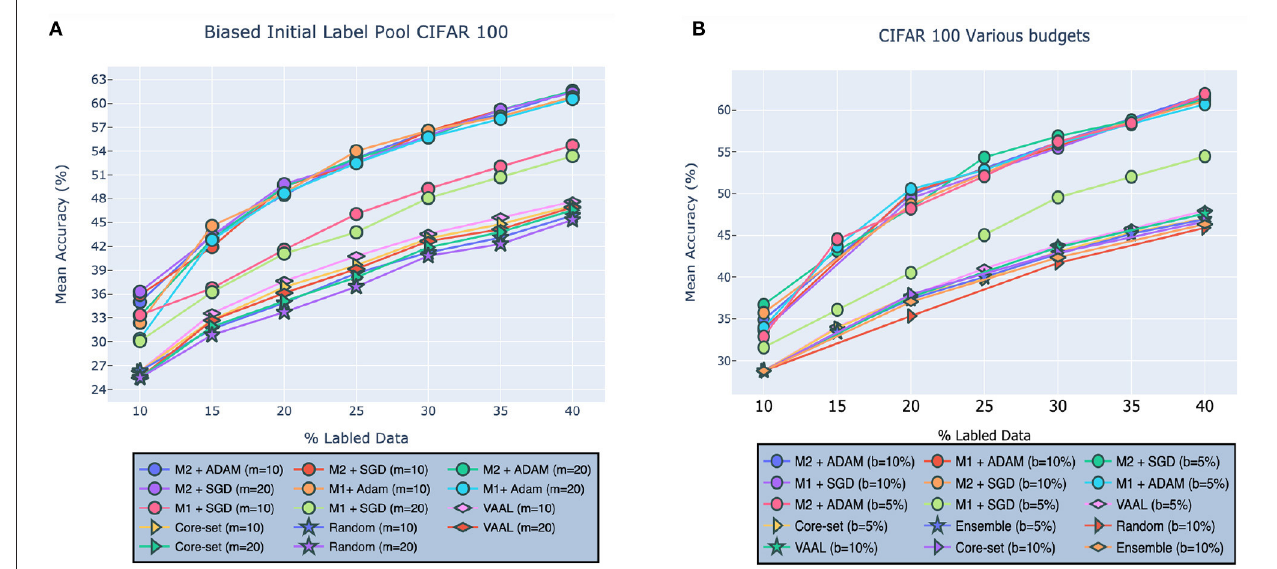
FIGURE 5 | Robustness of our approach on CIFAR-100 given (A) biased initial labeled pool or (B) different budget sizes compared to VAAL (Sinha et al., 2019), Core-set ( Sener and Savarese, 2017), Ensembles w. VarR (Beluch et al., 2018), MC-Dropout (Gal and Ghahramani, 2016), DBAL (Gal et al., 2017), and Random Sampling. M1 indicates our model (2) and M2 indicates our model (1). Best visible in color. Prior results adapted from Sinha et al.